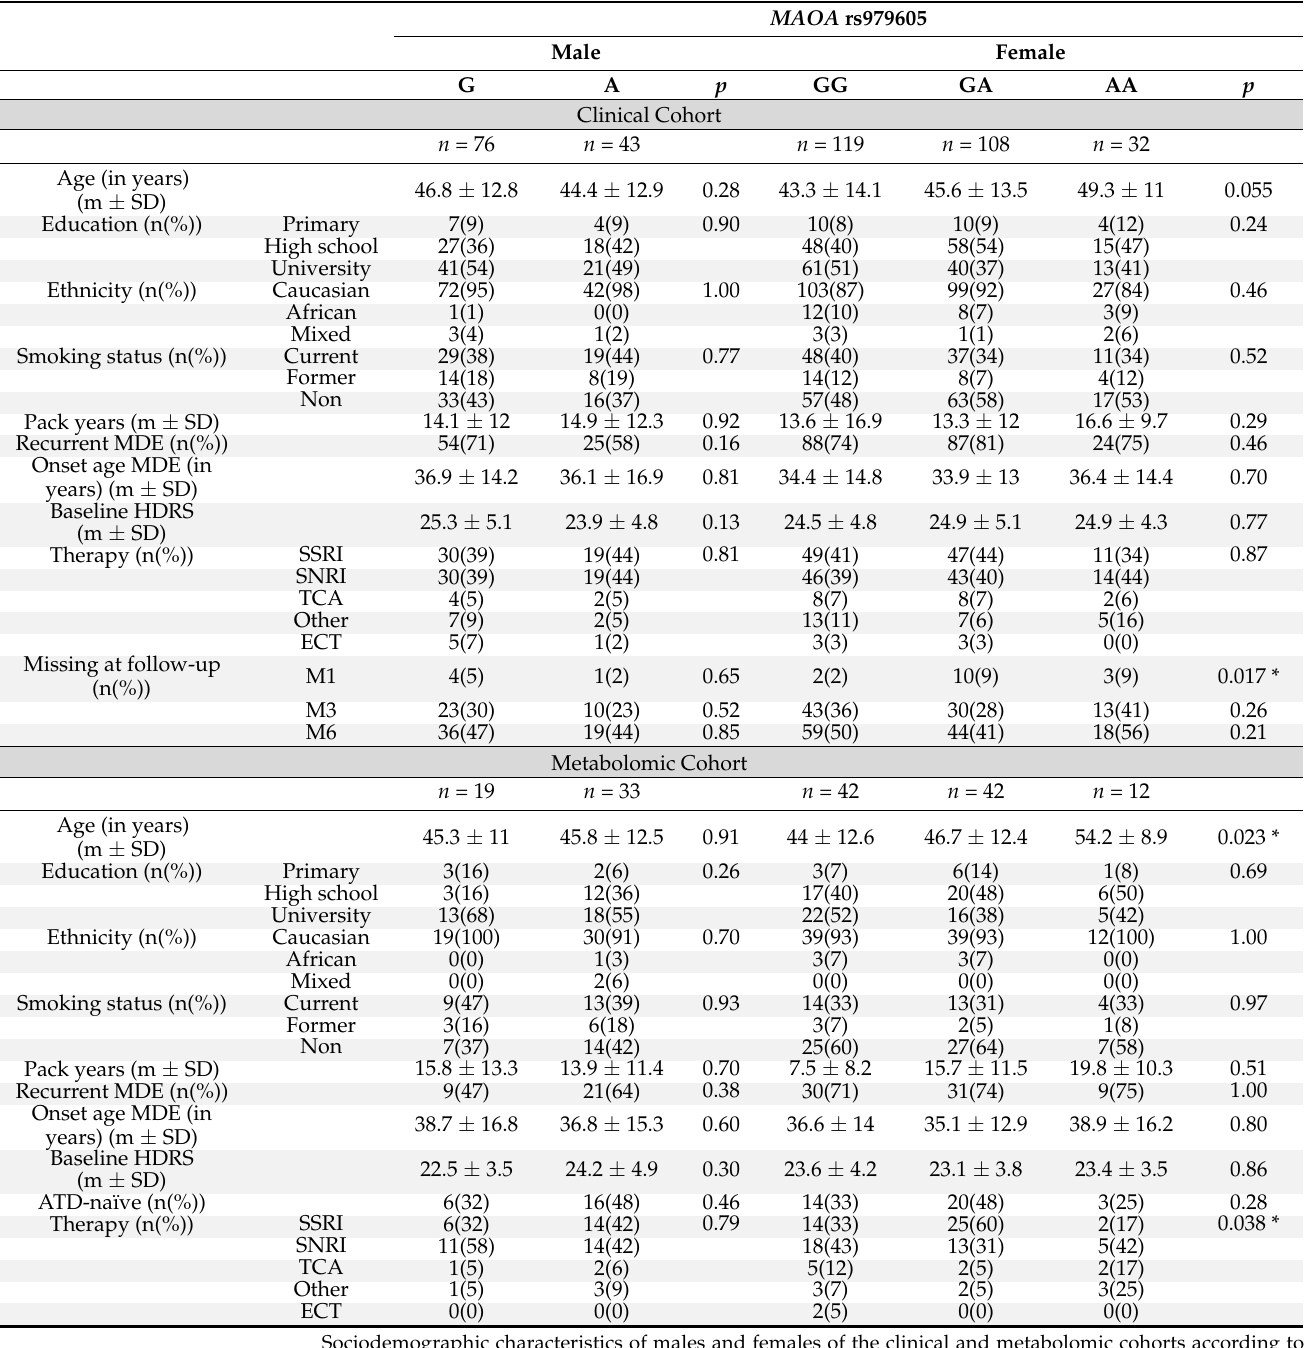
Table 3. Sociodemographic characteristics according to MAOA rs979605 genotypes in males and